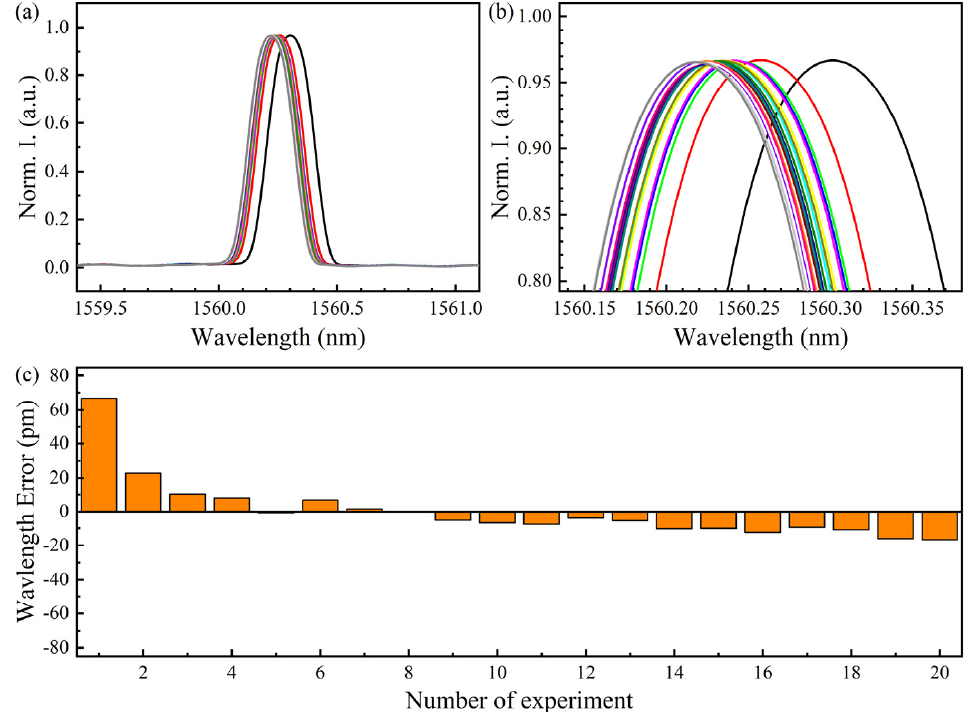
Figure 8. Results of repeated strain measurements: ( a ) normalized spectrum of the 20 times beat frequency signal; ( b ) close view of beat frequency signal; ( c ) the wavelength deviation of 20 repeti- tions.